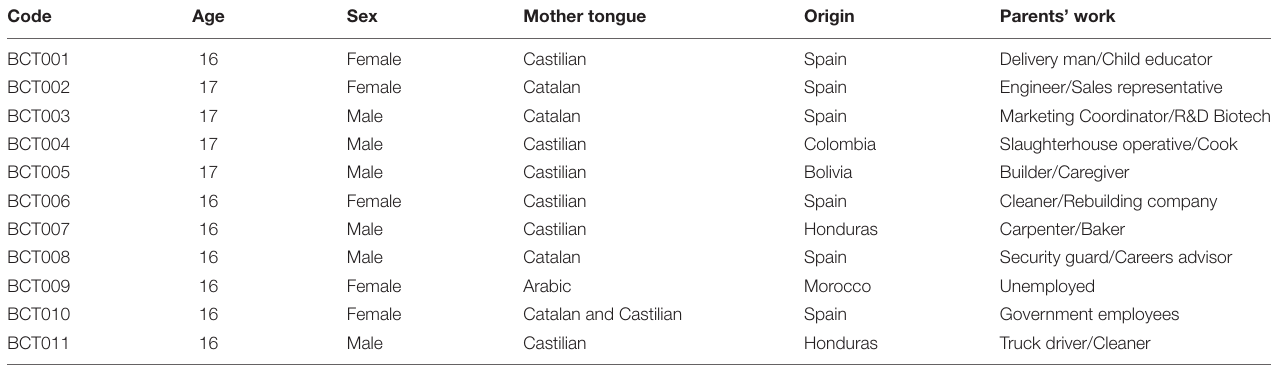
TABLE 1 | Sociodemographic characteristics of the sample.